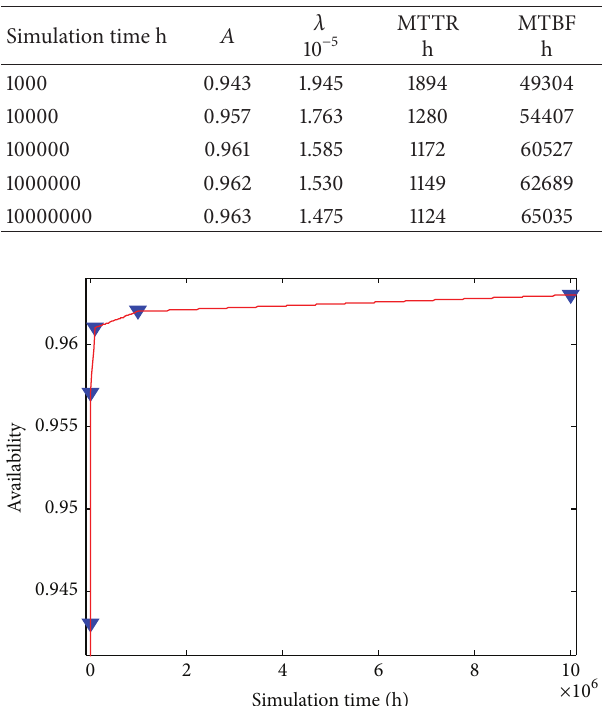
Table 5: Dynamic reliability parameters of servo valve.